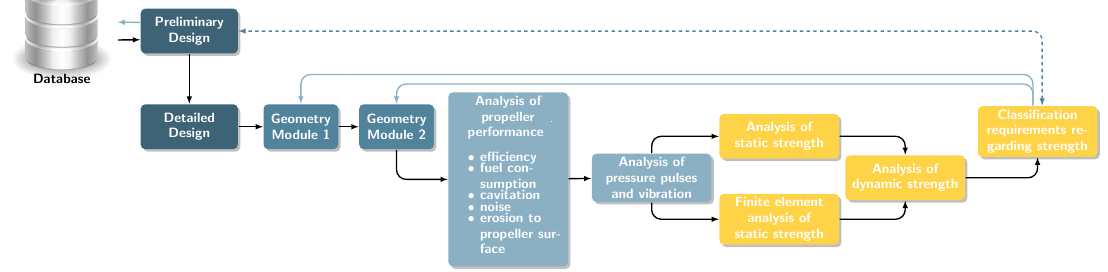
Figure 1. Manual design process and